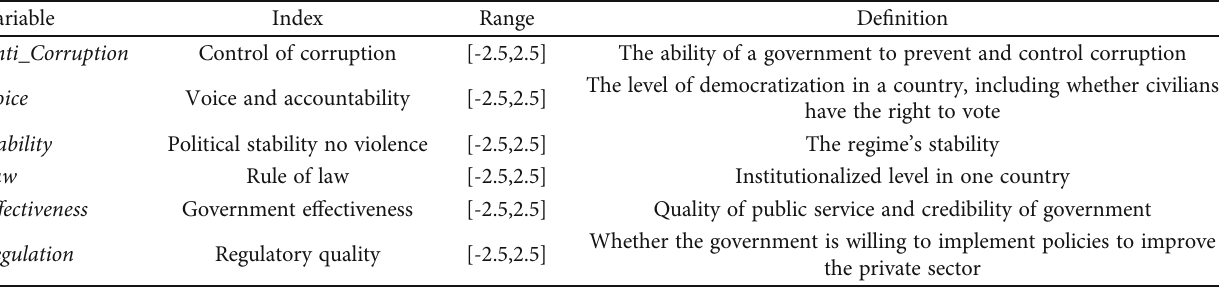
Table 5: The summary of the Institution